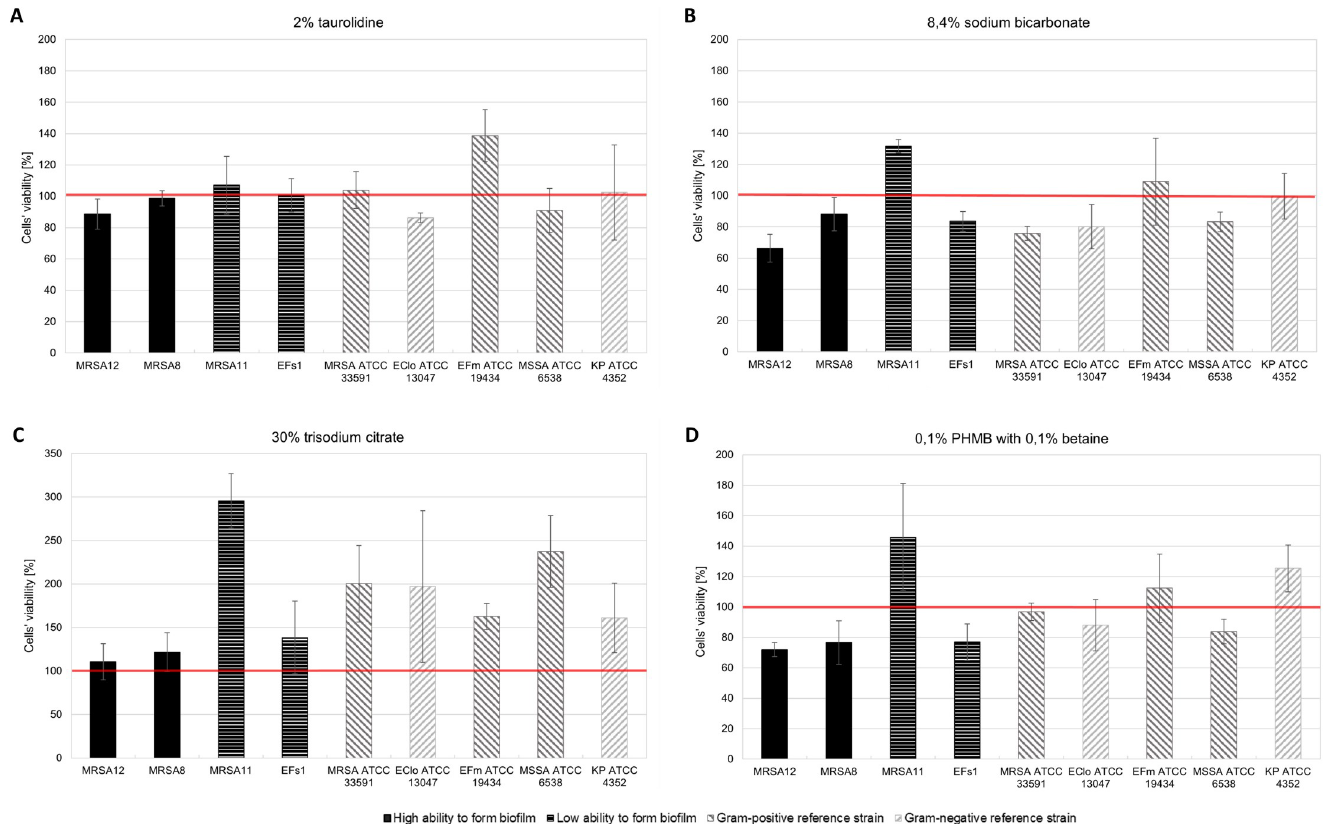
Fig 4. Anti-biofilm activity of compounds against biofilm formed on the dialysis catheter. (a) 2% taurolidine, (b) 8.4% sodium bicarbonate (c) 30% trisodium citrate, (d) 0.1% polyhexanide with 0.1% betaine (PHMB-B). The red line shows the metabolic activity of the bacteria in control [%]; MRSA–methicillin-resistant Staphylococcus aureus , MSSA–methicillin-sensitive Staphylococcus aureus , EFs– Enterococcus faecalis , EFm– Enterococcus faecium , EClo– Enterobacter cloacae , KP– Klebsiella pneumoniae , ATCC–American Type Culture Collection.